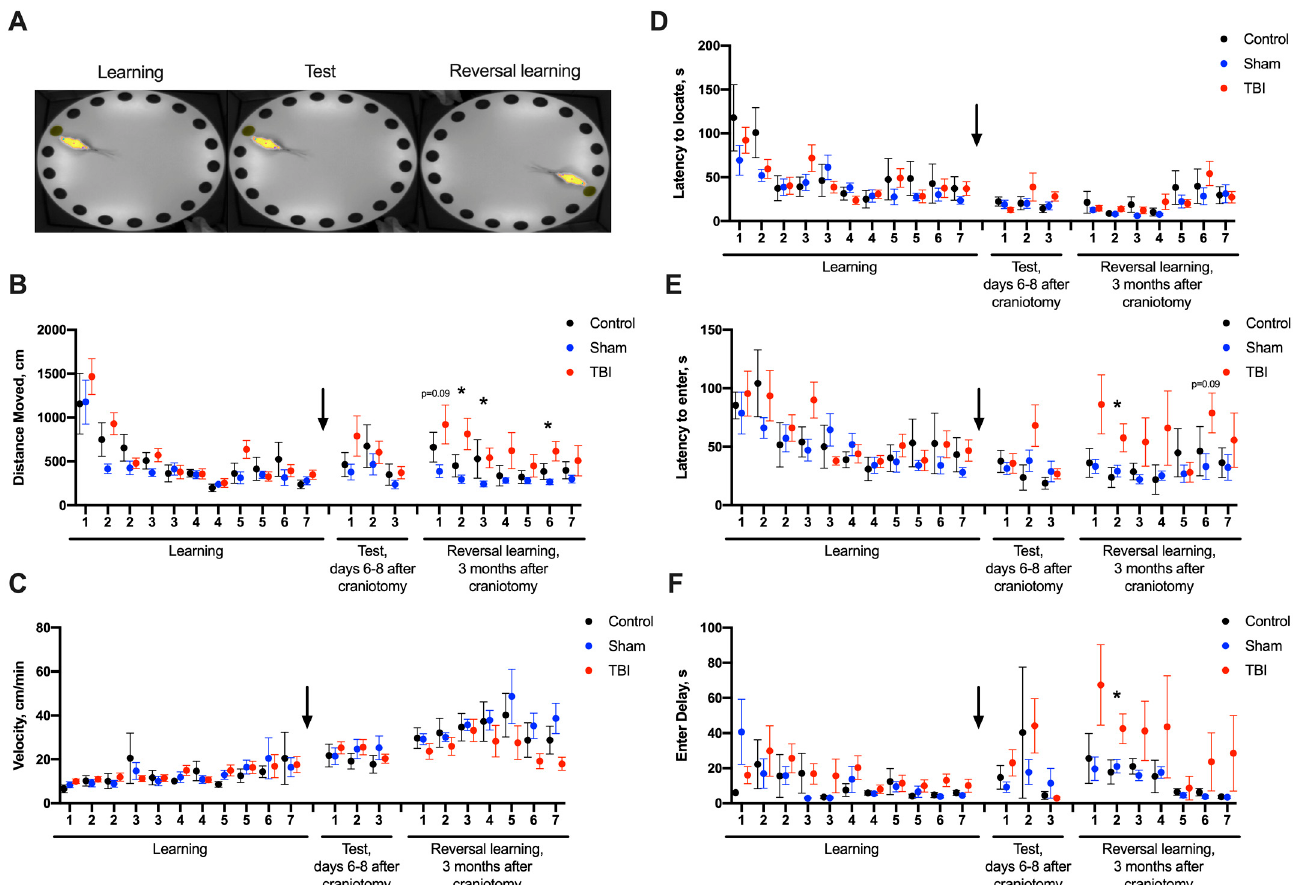
Figure 3. Behavior of rats in the Barnes maze in the acute and remote (3 months) periods after TBI. ( A )—Order of behavioral assessments. ( B )—Distance moved. Three months after craniotomy, animals after TBI tended to travel a longer distance to the previously learned position on test day 1. During reversal learning tests, the moved distances were higher on days 2, 3 and 6 of reversal learning 3 months after TBI. ( C )—Velocity during tests. ( D )—Latency to locate escape tunnel. ( E )—Latency to enter escape tunnel. The latency to enter was higher in animals with TBI on days 2 and 6 of reversal learning 3 months after TBI. ( F )—Enter delay. The delay to enter the escape tunnel before the first finding was higher on day 2 of reversal learning 3 months after TBI. *— p < 0.05, Kruskal–Wallis test. Black arrow indicates LFPI on the timeline.